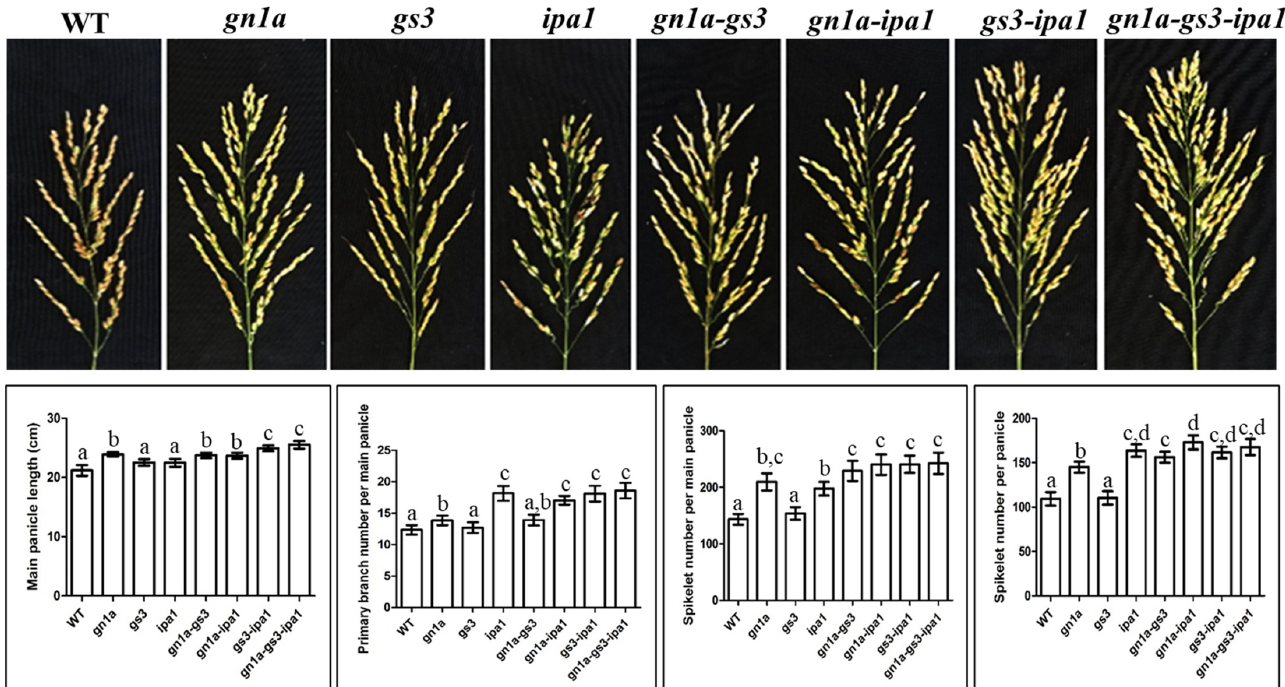
Figure 1. Representative main panicle architectures, main panicle length, the number of primary branching per main panicle, the number of spikelet per main panicle, the number of spikelet per panicle of the T3 generation. Means labeled with different lower letters are significantly different by the Duncan Multiple Range Test at p < 0.05 using the SPSS software package version 17.0 (SPSS Inc., Chicago, IL, USA).